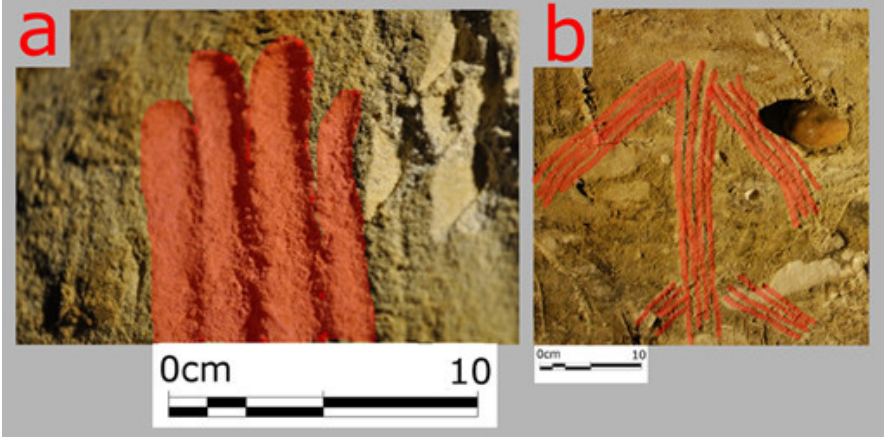
Figure 10. In Rouffignac the (a) left hand finger profile of the child (34mm) which indicates that she was female, in Chamber A2, and (b) her tectiform in Chamber